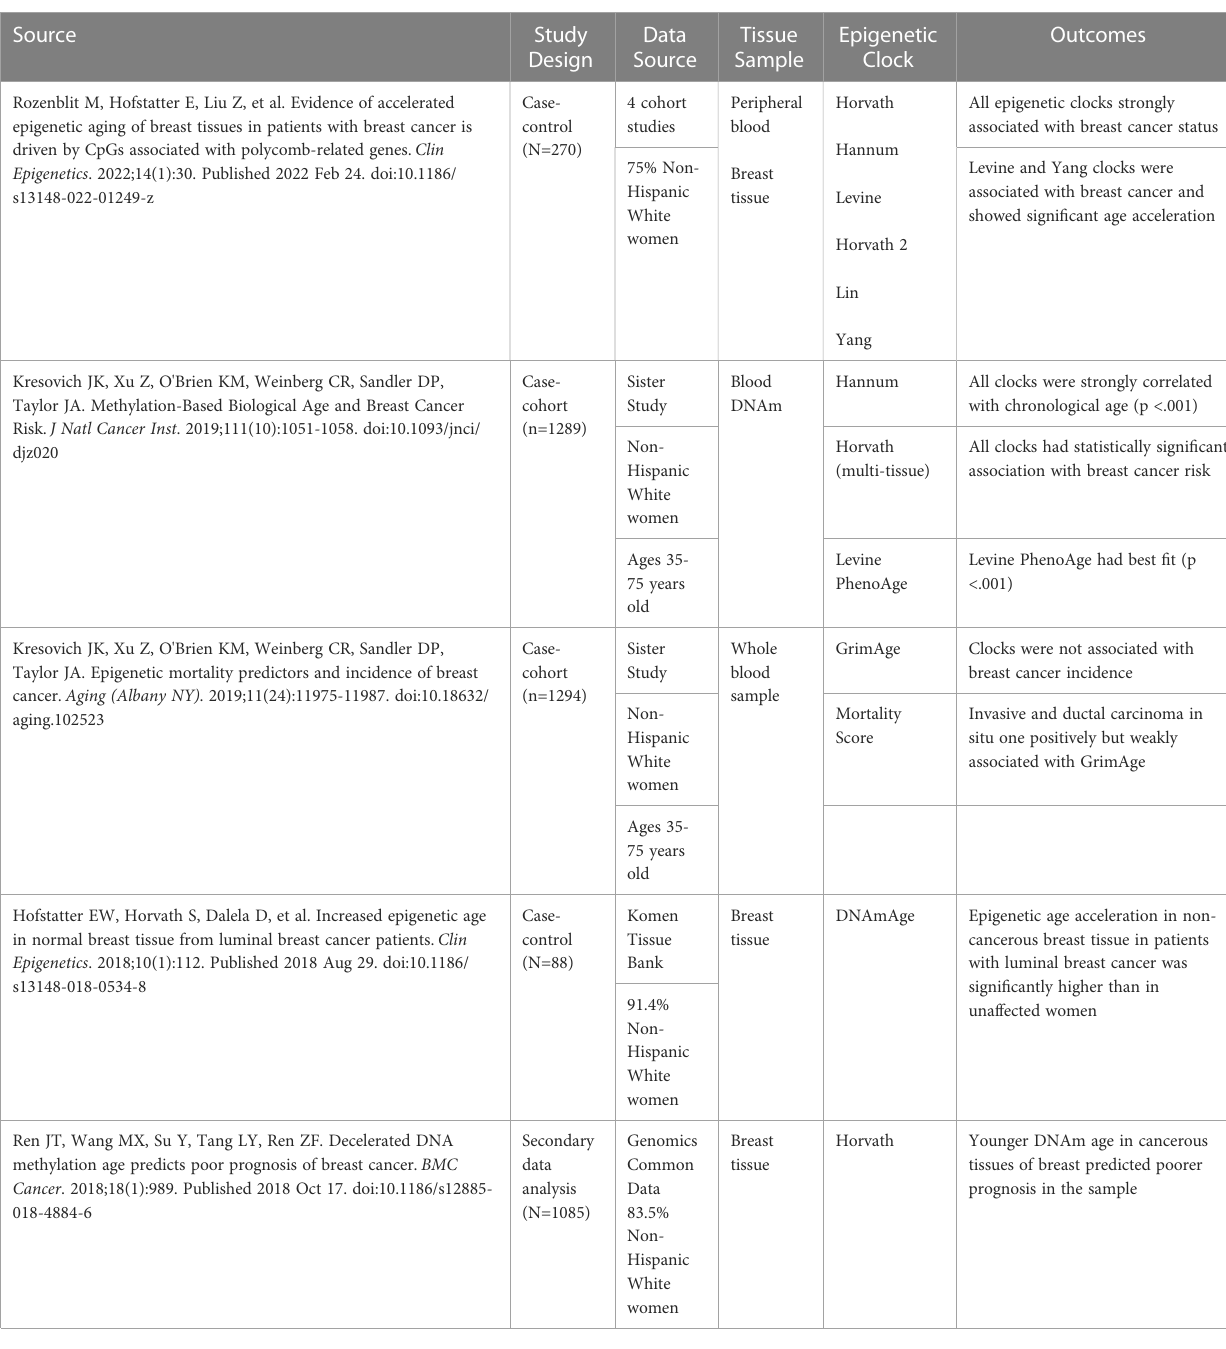
TABLE 1 Studies Included in